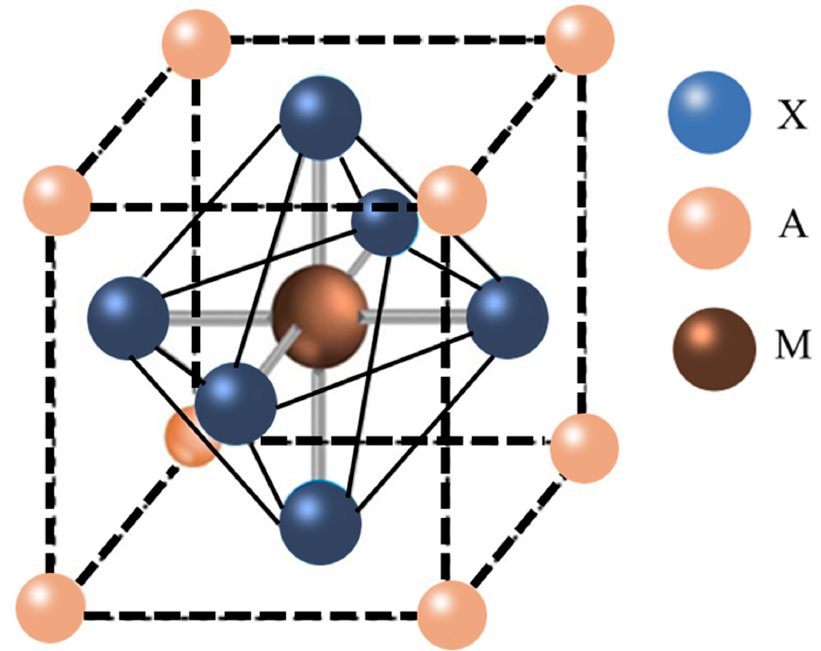
Figure 1. A typical perovskite structure.